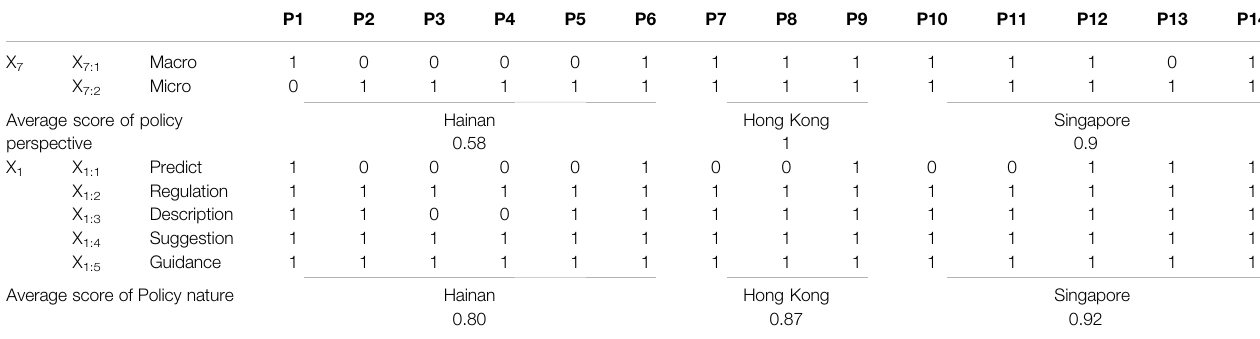
TABLE 7 | Hainan Tropical Rainforest National Park policies lack predictive, descriptive strategic